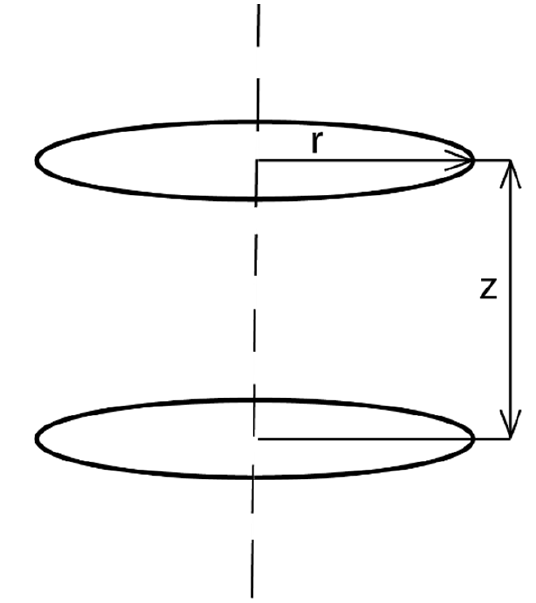
Figure 1. Diagram of z and r coordinates with respect to primary and secondary coils.